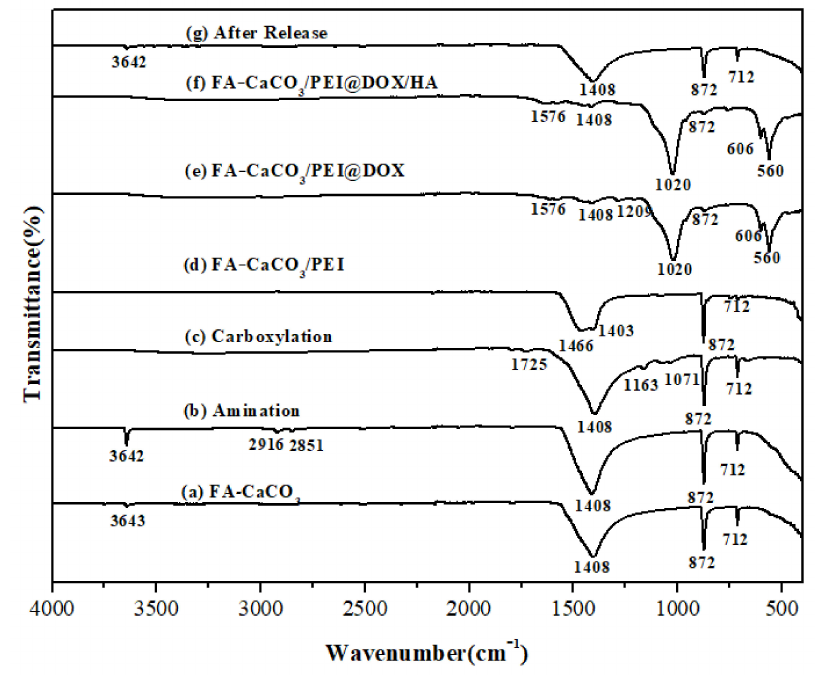
Figure 4. FT-IR spectra of the ( a )FA-CaCO 3 , ( b ) Aminated FA-CaCO 3 , ( c ) Carboxylated FA-CaCO 3 , ( d ) FA-CaCO 3 /PEI, ( e ) FA-CaCO 3 /PEI@DOX, ( f ) FA-CaCO 3 /PEI@DOX/HA, and ( g ) CaCO 3 micro- spheres after drug release.